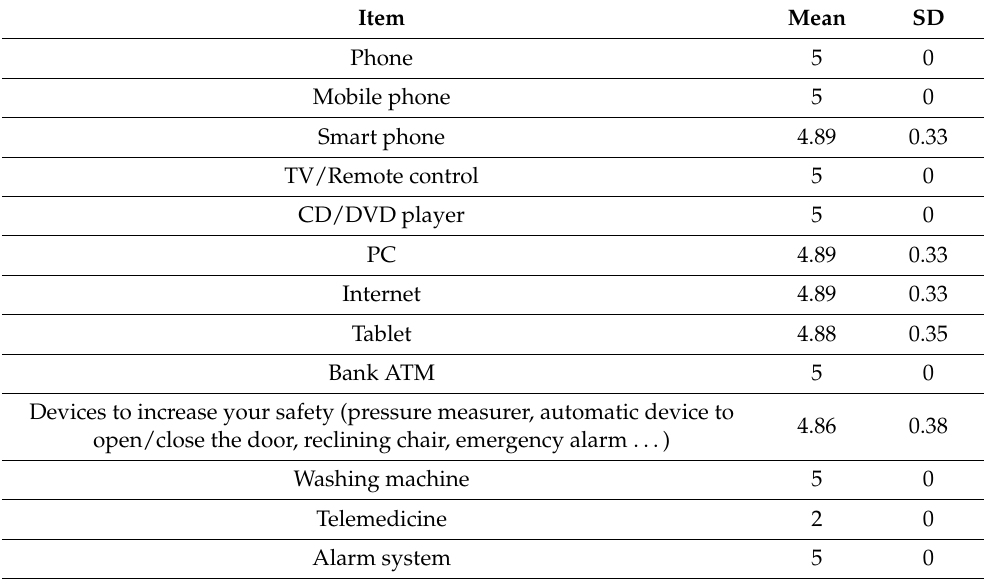
Table 2. Attitude toward technology in informal caregivers.